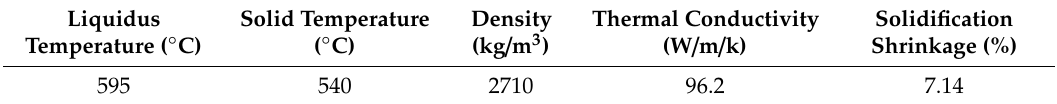
Figure 4. ( a ) 3D model for sand casting system, ( b ) 3D model for 3DP casting system. Table 2. Thermophysical parameters of the cast